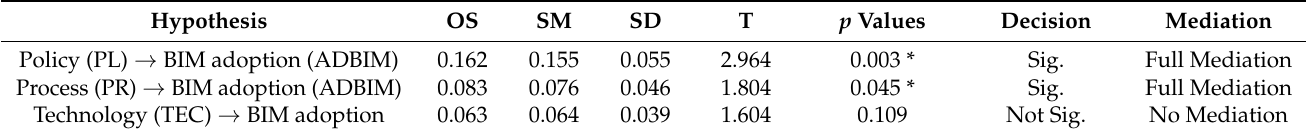
Table 13. Mediation